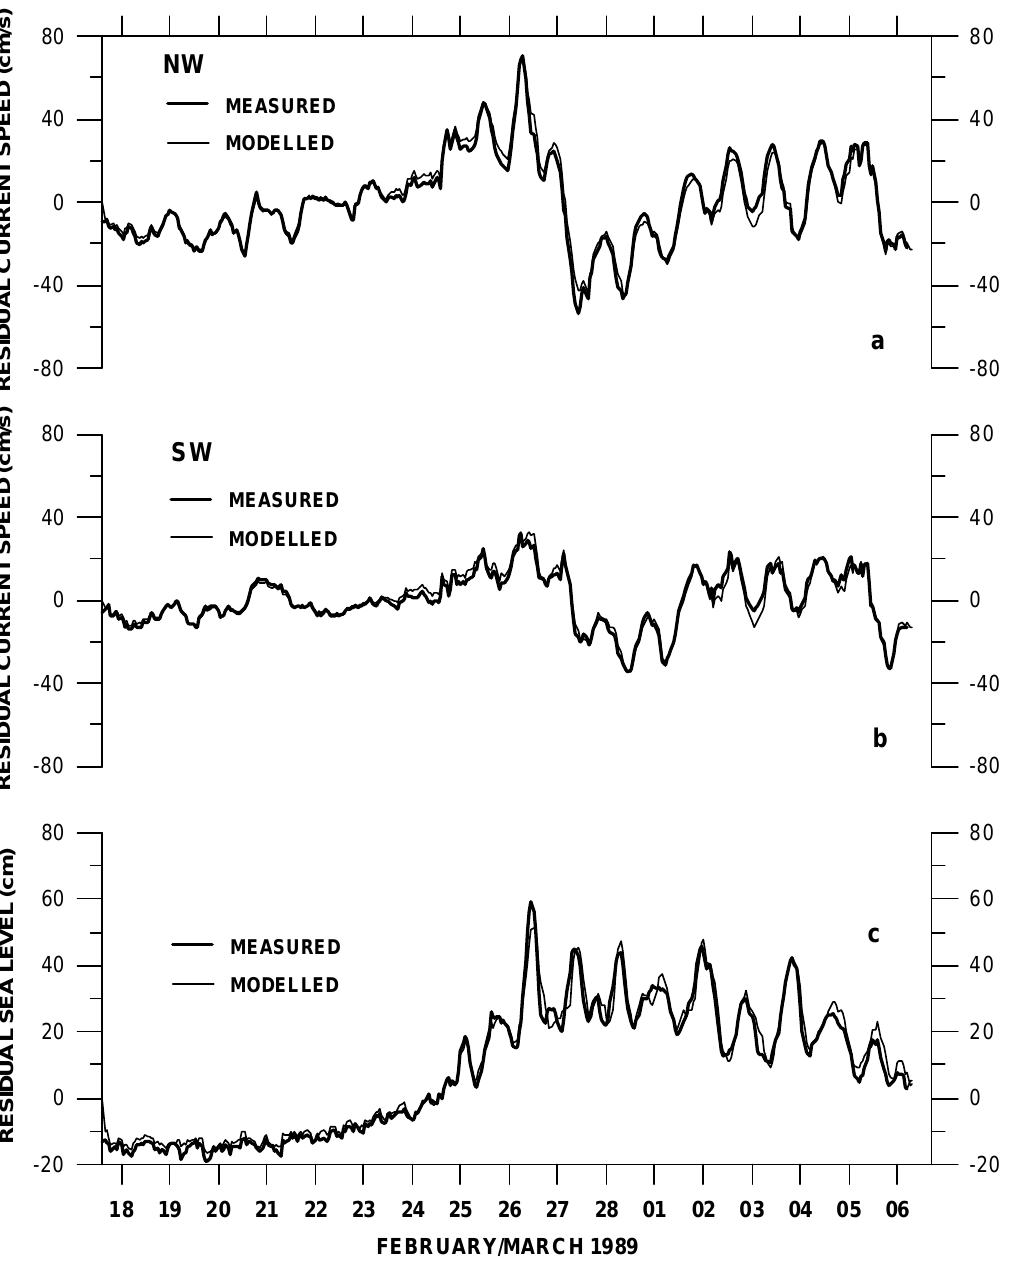
Fig. 12. Comparison between measured and modelled hourly residual (a) NW and (b) SW components of currents at station L-1 (nominal depth of 20m) and (c) sea levels at